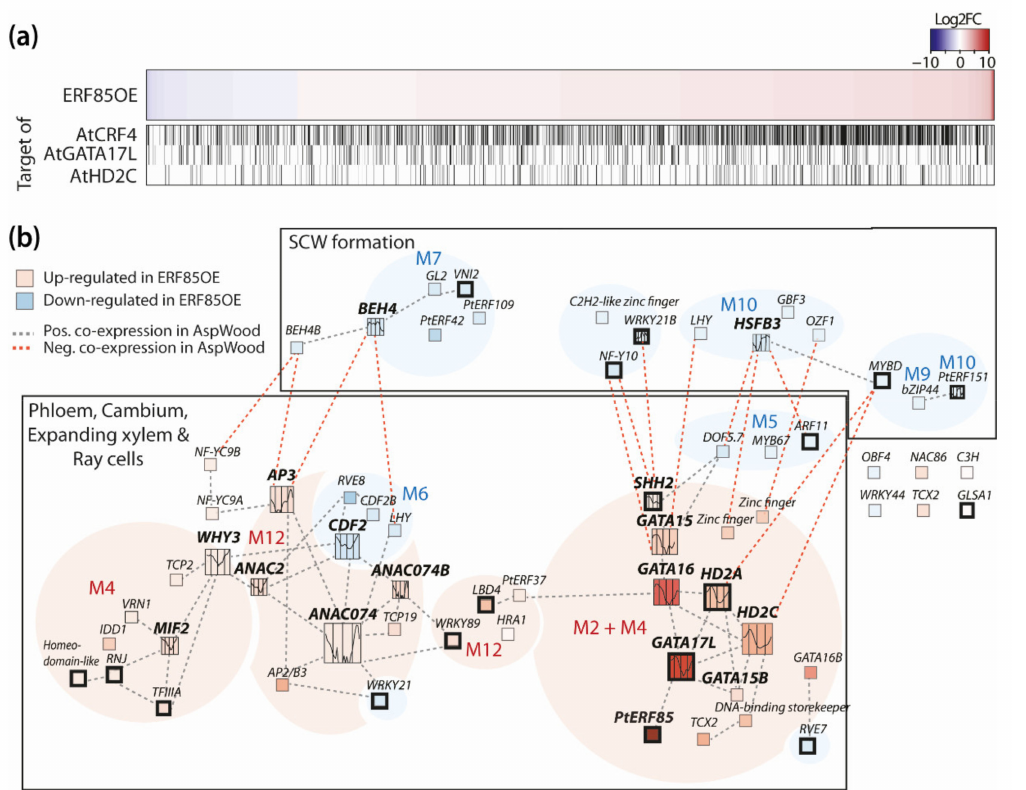
Figure 6. Potential PtERF85-controlled gene regulatory networks during wood development. ( a ) Heatmap showing the gene expression of all DEGs in ERF85OE compared to WT. The graphs beneath the heatmap indicate homologs that were identified as direct targets of AtCRF4, AtGATA17L, and AtHD2C in Arabidopsis (Table S2; [35,37,38]). ( b ) Co-expression network of differentially expressed TFs in ERF85OE during wood development (Table S9). Thickened box lines indicate TFs for which homologs were identified as direct targets of AtCRF4 in Arabidopsis [37]. Background color represents gene expression induction (red) or suppression (blue) in ERF85OE lines compared to WT. TFs with at least four neighbors were highlighted by increased box size and expression profiles inside the box show their expression pattern during wood formation (obtained from the AspWood database [3]). Grey lines indicate positive co-expression between the TFs, red indicates negative co-expression. M = module (corresponding to Figure